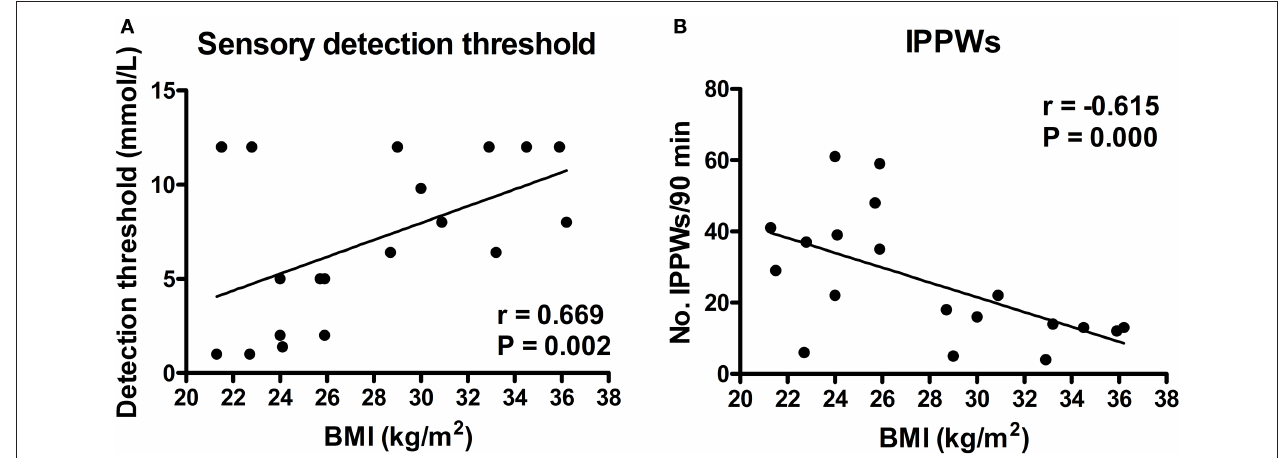
Figure 2 | relationship between (A) oral detection threshold for oleic acid (C18:1) and (B) the total number of isolated pyloric pressure waves (IPPWs) following intraduodenal infusion of C18:1 (0.76 kcal/min for 90 min), with body mass index (BMI, kg/m 2 ) in both lean ( n = 10) and obese ( n = 9) subjects (Stewart et al.,